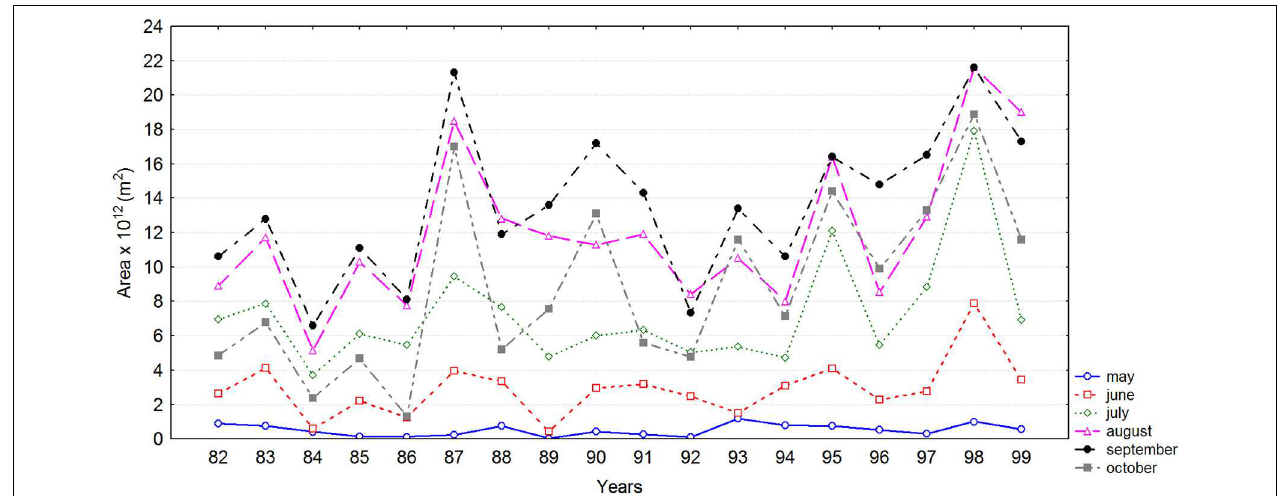
FIGURE 7 | Annual time series of AWP area, 1982–1999.